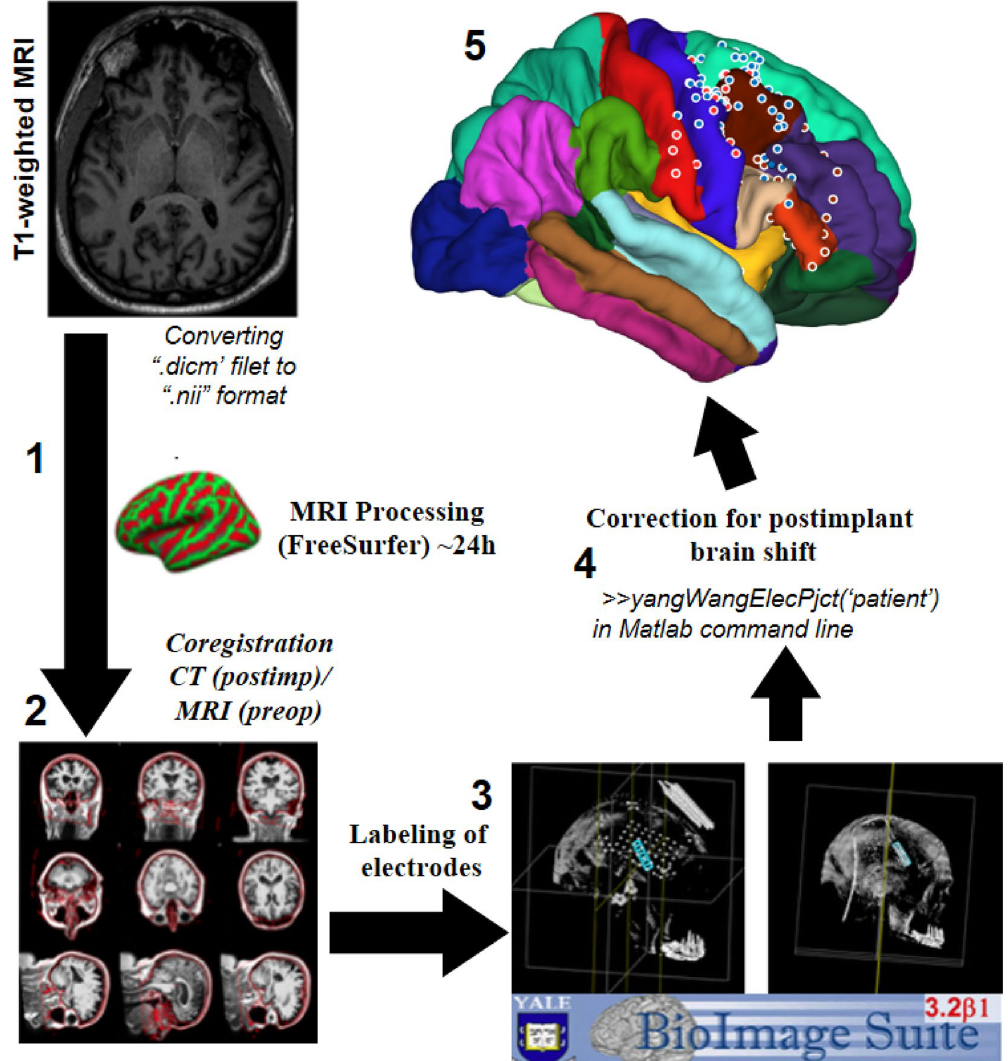
Figure 2. Algorithm of the image processing. (1) Processing of the T1-weighted MRI image using freesurfer(extraction of the pial surface and leptomeningeal surface, segmentation of brain structures); (2) Coregistration of the postimplant CT scan with processed MRI using iELVis coregistration tool; (3) Labeling of electrodes on coregistrated CT using Bioimage Suite 3. (4) Postimplantation brain shift correction using iELVis Yang, Wang et.al. tool. (5) Creating images of electrode locations. ( Source: http:// ielvis. pbwor ks.